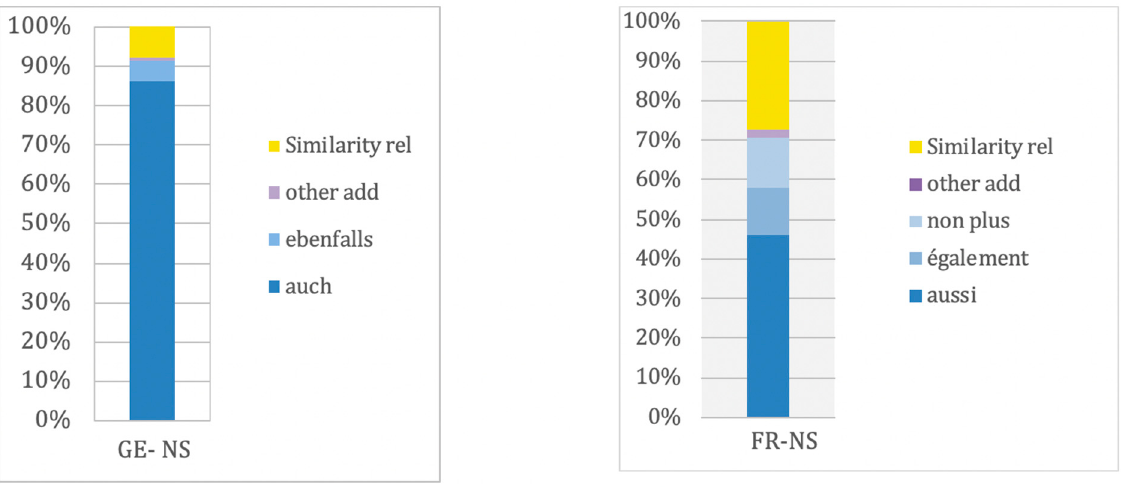
Figure 2. Proportion of additive means used by native speakers.